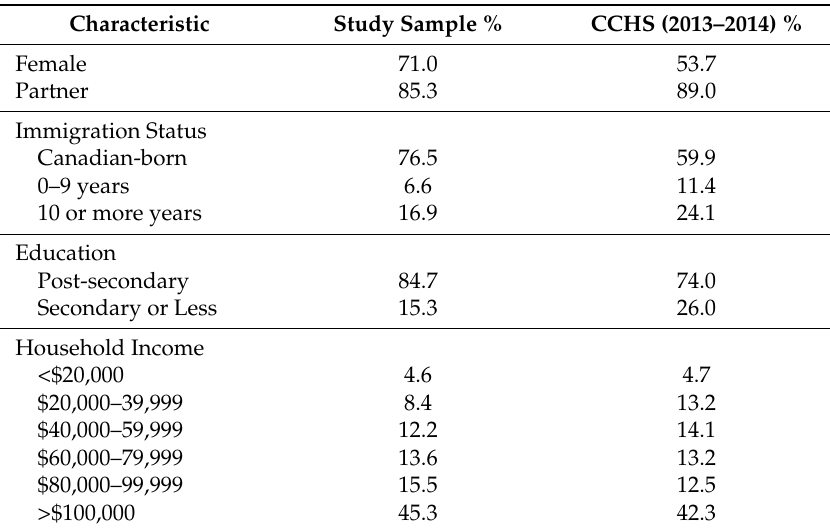
Table 1. Comparison of study sample with parents in CCHS